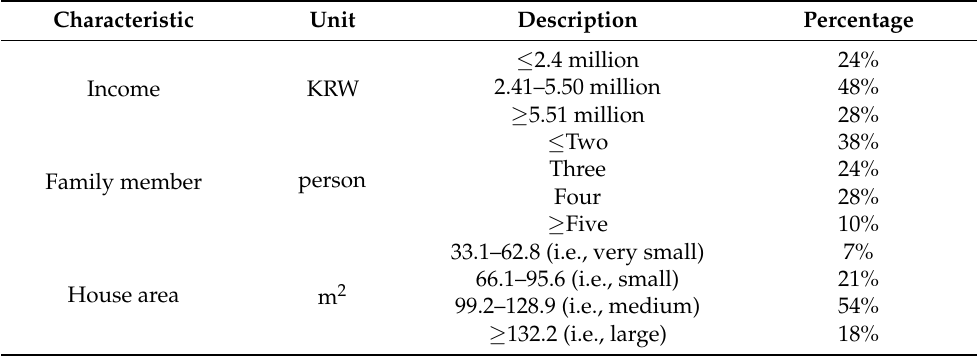
Table 3. Summary of demographic